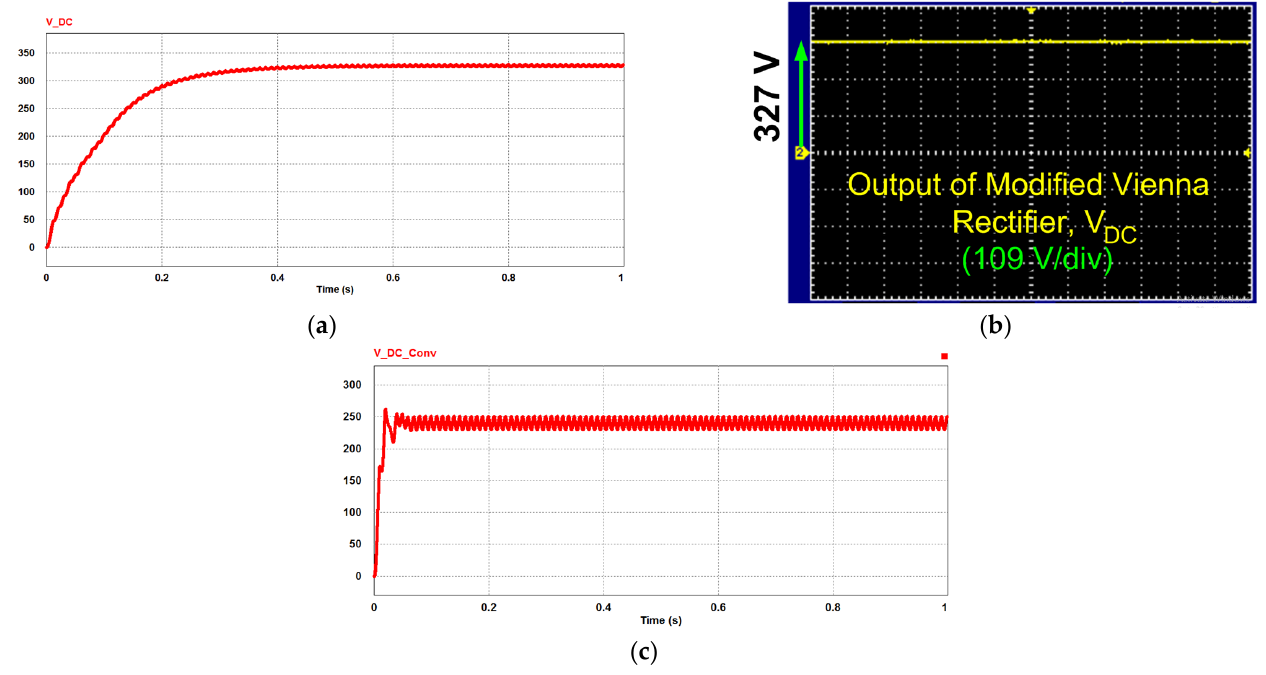
Figure 23. Experimentally obtained: ( a ) input voltage; and ( b ) input current.